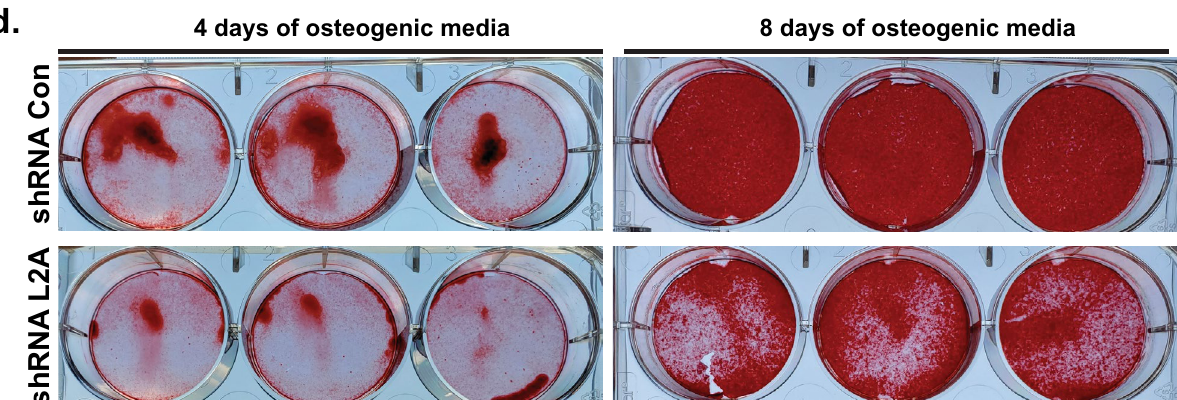
Figure 6. CMA deficiency increases RANKL expression and decreases mineral deposition of an osteoblastic cell line. Lamp2a was knocked down in osteoblastic UAMS-32 cells and plated into 6 well plates for gene expression or mineralization assays. ( a–c ) qRT-PCR analysis of three Lamp2 isoforms and Tnfsfs11 (Rankl) in osteoblastic UAMS-32 cells that stably express scrambled shRNA (shRNA Con) or shRNA targeting LAMP2A (shRNA L2A). mRNA levels of all transcripts were normalized to the housekeeping gene β-actin. n = 6 wells/ group. Bars indicate mean ± STDEV. p values were calculated and evaluated by Welch’s t -test; *, p < 0.05. Knockdown of Lamp2a and the following gene expression was performed an additional time independently and shown in S. Fig. 6a–c. ( d ) shRNA Con and shRNA L2A cells were cultured in osteogenic media. Mineral deposition was measured by Alizarin Red staining on day 4 and day 8 of